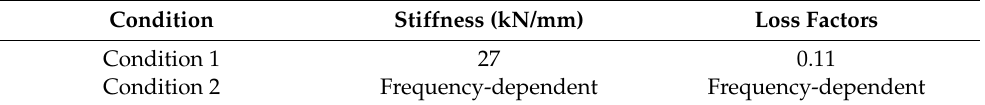
Table 2. Calculation condition.